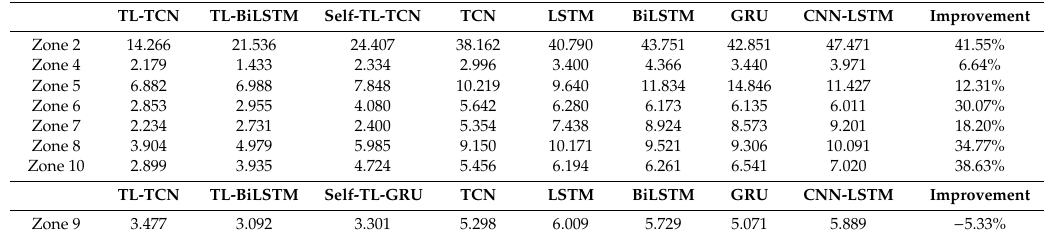
Table 15. MAE score when zone 3 is the source domain.